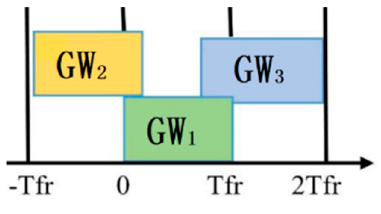
Figure 2. Pure ALOHA.